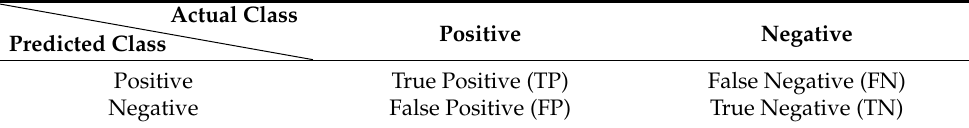
Table 1. Confusion matrix.